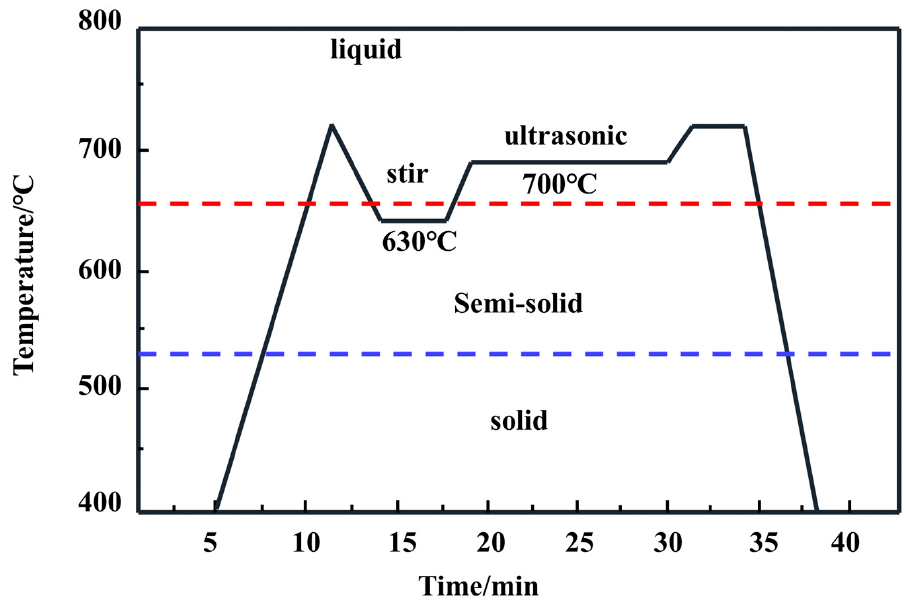
Figure 2. Flow chart of smelting process.